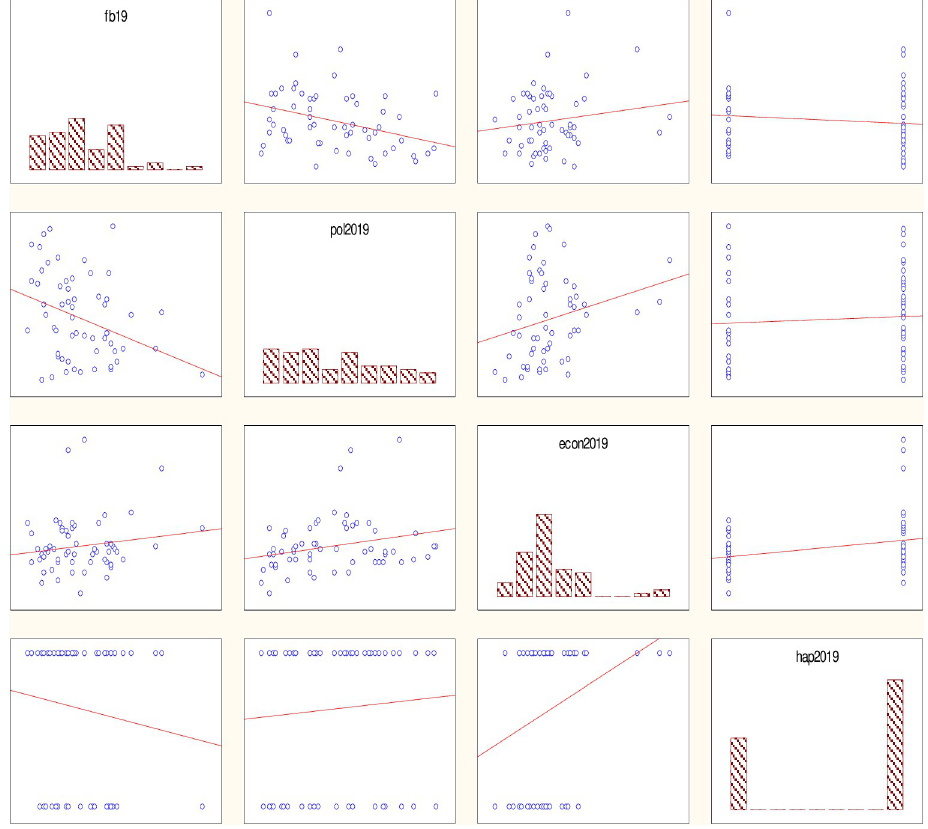
Fig 2. Results of the logit model for assessing the economic, financial, budgetary and political-institutional development as a result of the pandemic. Source: own